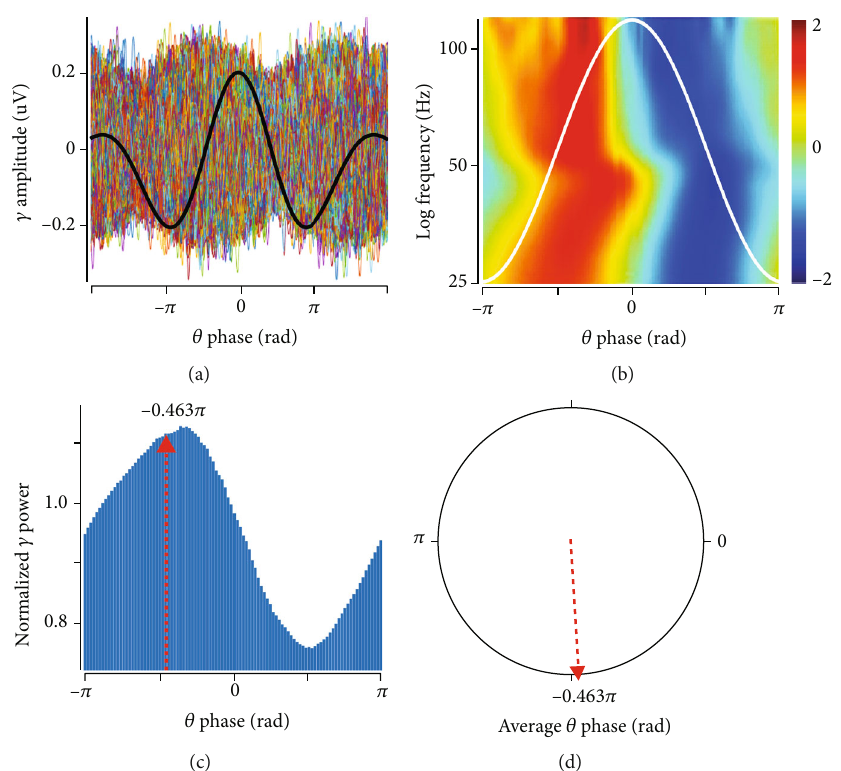
Figure 2: θ -to- γ phase-amplitude coupling (PAC) analysis process. (a) Filtered LFP in θ (black trace) and γ bands (coloured traces) are represented; θ trace is the average of n theta cycles, aligned around their maximum amplitude (downscaled to fi t γ amplitude); each θ cycle-concurrent γ activity is presented in superposition using the abovementioned alignment. (b) Average normalized γ band scalogram (colour scale) relative to the θ phase (illustrated as a white trace). (c) Normalized γ band spectral power average as a function of the θ phase. (d) Average vector of (c) indicating dominant-phase θ -to- γ